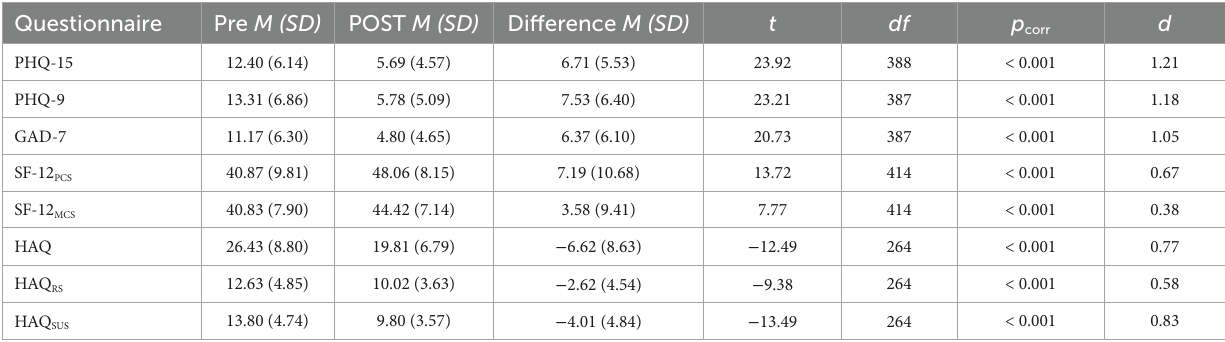
TABLE 4 Patient outcomes.